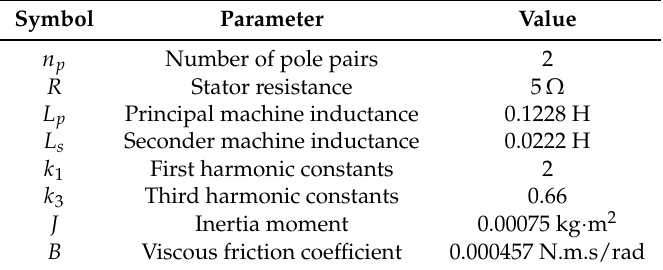
Table 1. 5-phase PMSM Parameters.